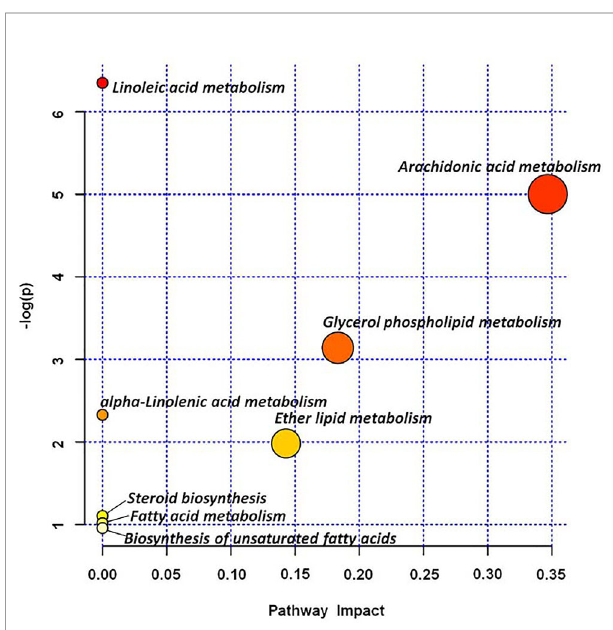
FIGURE 4 | Metabolic pathway analysis of potential biomarkers in the serum generated using MetPA.